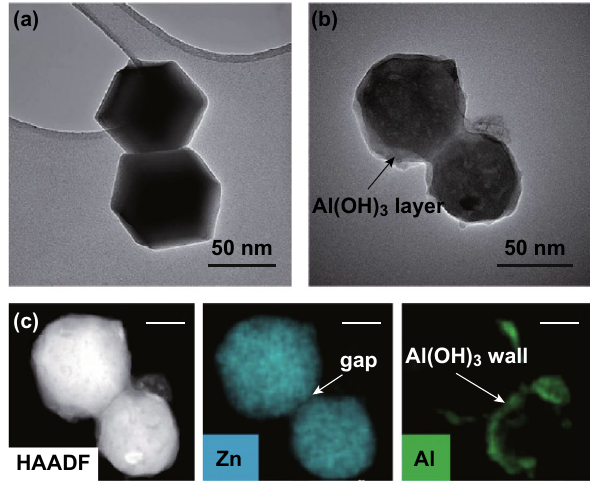
Fig. 8 Investigation of the formation mechanism of pATH through TEM. a TEM image of the ZIF‑8‑2 h template; b TEM image of the intermediate gathered after a reaction time of 10 min; c HAADF image and elemental mapping (scale bar: 20 nm). Adapted from Ref. [55] with permission from the Royal Society of